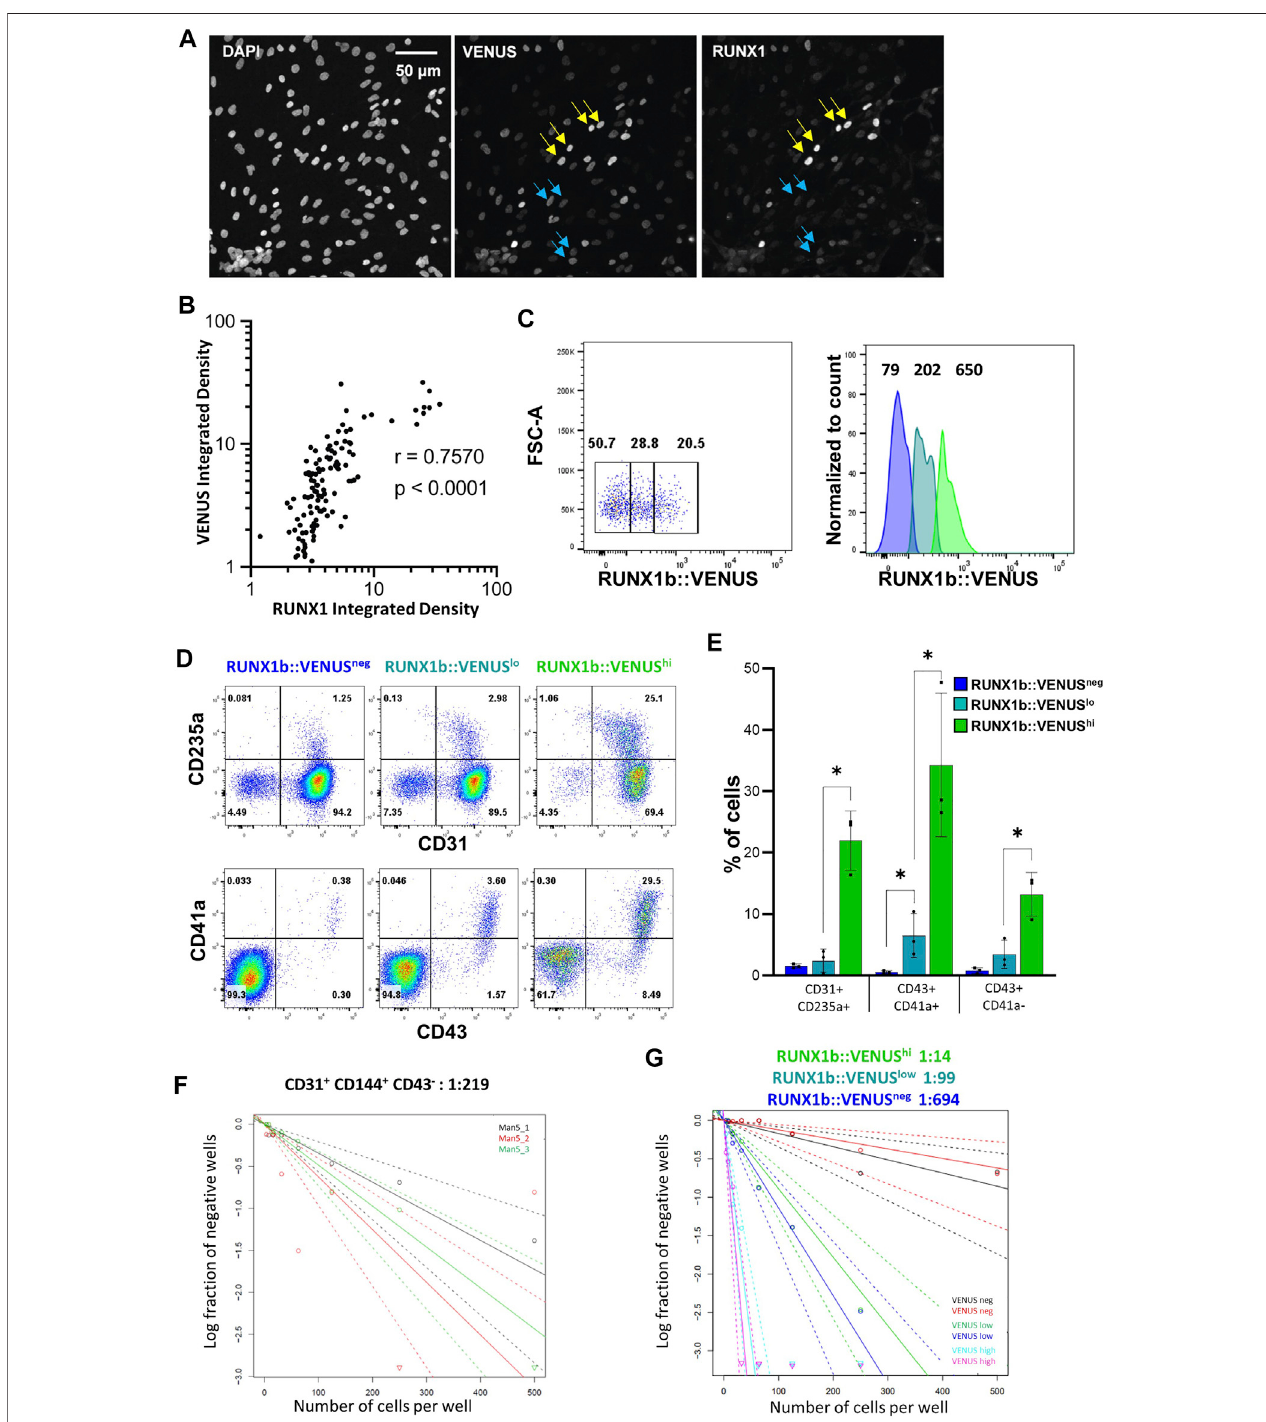
FIGURE 4 | RUNX1b expression level determines hemogenic competency. (A) CD31 + CD43 − cells were sorted from day 6 EBs, grown for 1 day on glass slides in hemogenicinducingconditionsthenstainedandanalyzedforDAPI,VENUSandRUNX1expression(yellowarrows:cellswithhighexpression,bluearrows:cellswithlow expression).VENUSisnuclearasaH2B-VENUSfusionproteinreporterconstructwasusedtotargettheRUNX1blocus. (B) Foreachindividualcell,VENUSandRUNX1 signals were integrated, plotted against each other and Pearson correlation coef fi cient (r) calculated. (C) Gating strategy for the isolation of VENUS negative, low and high populations from CD31 + CD43 − day 6 EBs. Numbers on the dot plot represent frequencies (%) and, on the histogram, mean fl uorescence intensities. (D) Flow cytometry analysis for the indicated cell surface markers at day 4 of hemogenic inducing cultures for the sorted VENUS negative, low and high cell populations. (E) Frequenciesofhematopoieticcellsatday4ofhemogenicinducingculturesfrom3independentexperiments,dataarepresentedasmean+/ − SD.Statisticallysigni fi cant differenceswereanalyzedwithunpaired t -test* p < 0.05. (F,G) Limitingdilutionanalysisofhemogenicpotentialintheindicatedpopulations.Alldataarerepresentativeof at least 3 independent experiments.